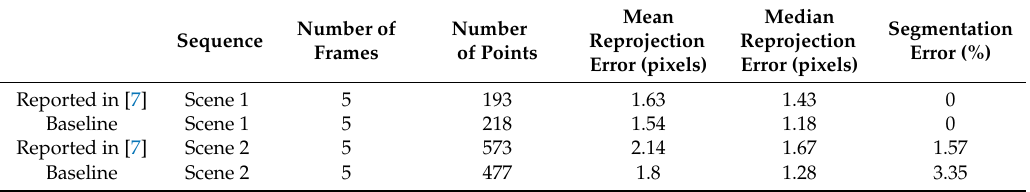
Table 3. Reprojection and segmentation errors obtained for Scene 1 and Scene 2.